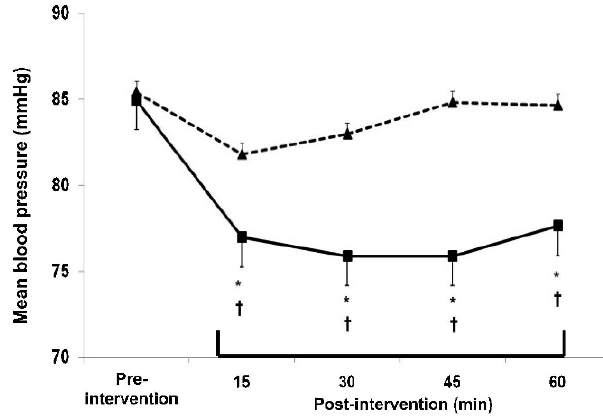
Figure 3 - Mean blood pressure measured pre-intervention, and at 15, 30, 45 and 60 minutes after the interventions in the control (dashed line with triangles) and the resistance exercise (solid line with squares) sessions. * Significantly different from pre-inter- vention (P , 0.05). { Significantly different from the control session (P